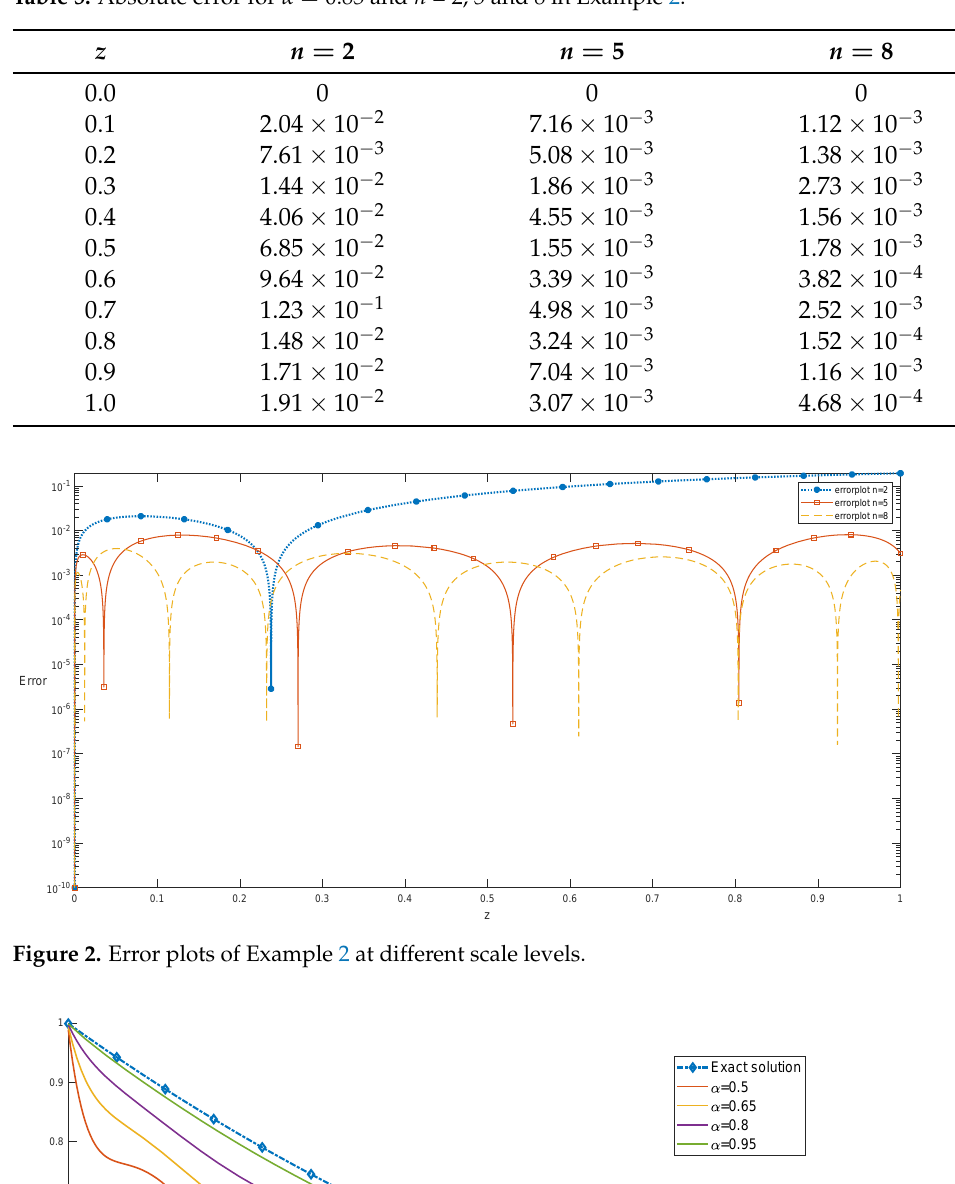
Table 5. Absolute error for α = 0.85 and n = 2, 5 and 8 in Example 2.